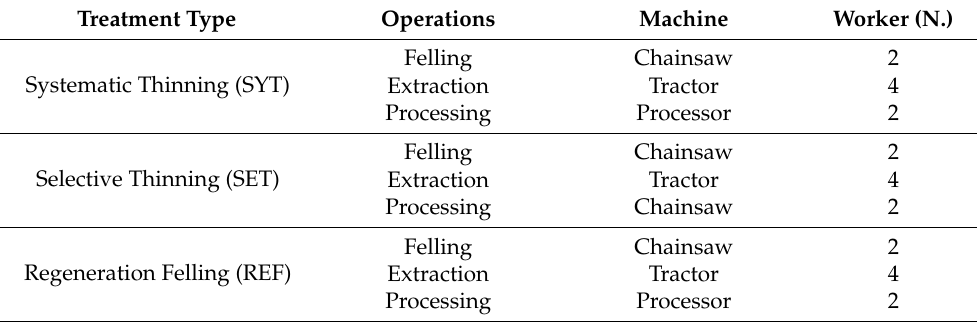
Table 1. Composition of the work yard in relation to the different work operations for the three treatment